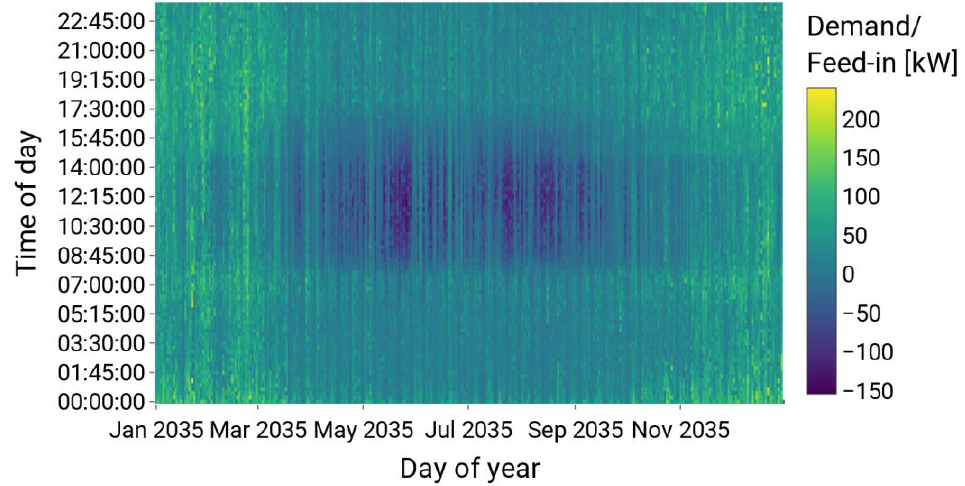
Figure A3. Heatmap of the electric demand (positive values) and feed-in (negative values) for the feeder fee scenario, the scenario year 2035 and the rural grid.